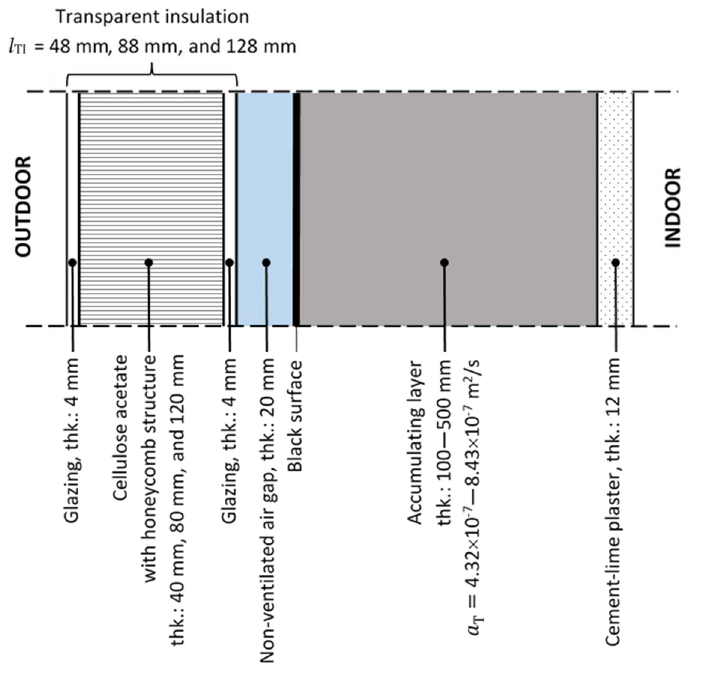
Figure 1. Layout of layers in the analyzed SWs with transparent